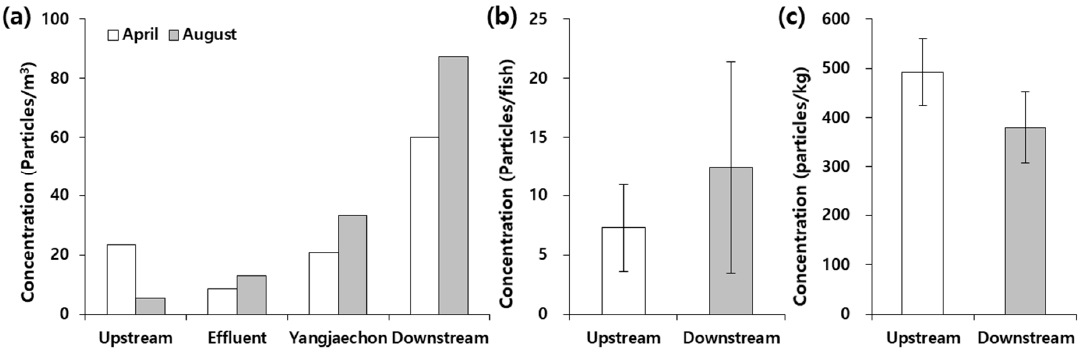
Figure 2. The concentration of microplastics in ( a ) surface water, ( b ) fish, and ( c ) sediment in Tanchon stream, Korea.